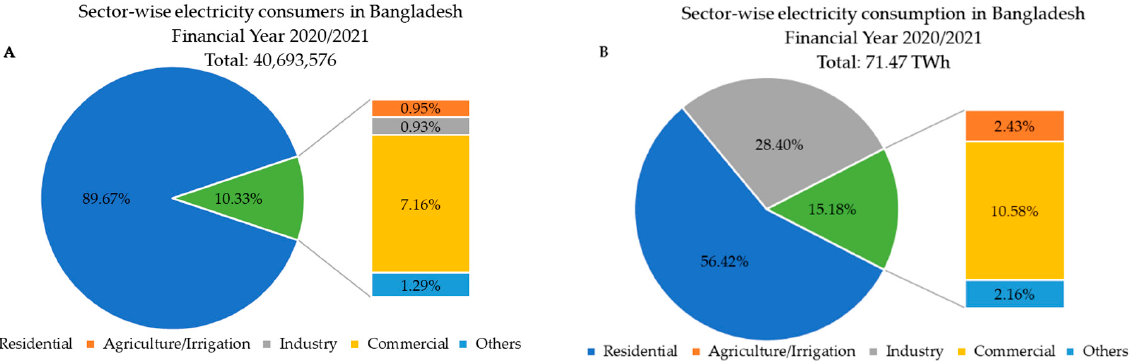
Figure 10. Sector-wise consumer ( A ) and energy consumption ( B ) in Bangladesh in the financial year 2020/2021. Data source: [9].